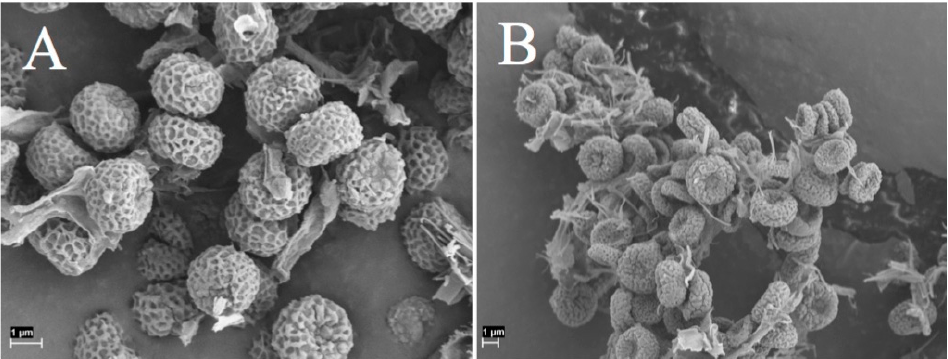
Figure 1. Chaenotheca furfuracea spores ( A ) collection from Tanzania, SGT 431. ( B ) collection from Sweden, SGT 441.